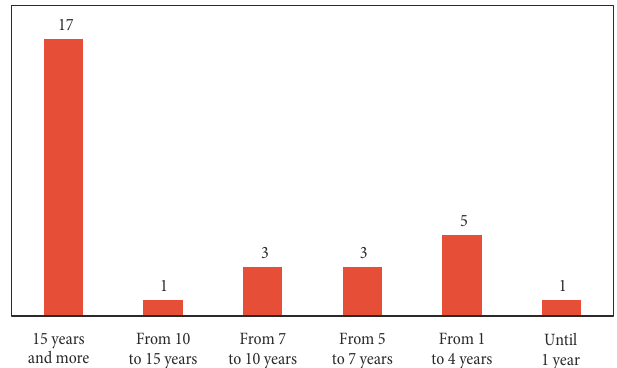
Fig. 1. Experts’ work experience in current occupation field, frequency of answers (number)